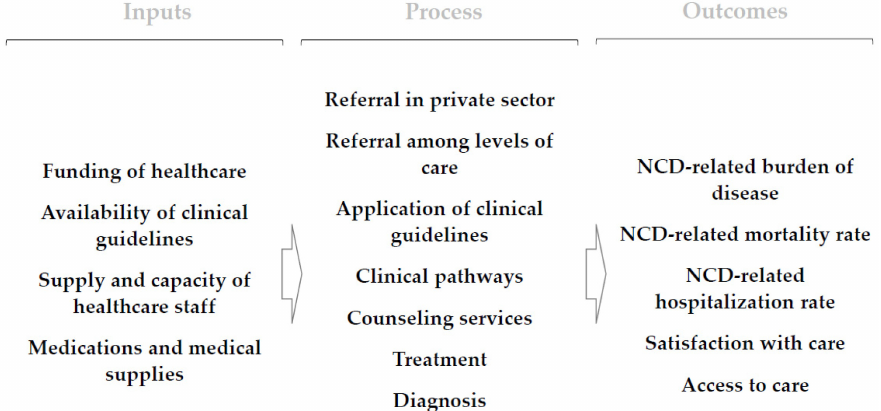
Figure 1. The conceptual framework for analysis of NCDs management in